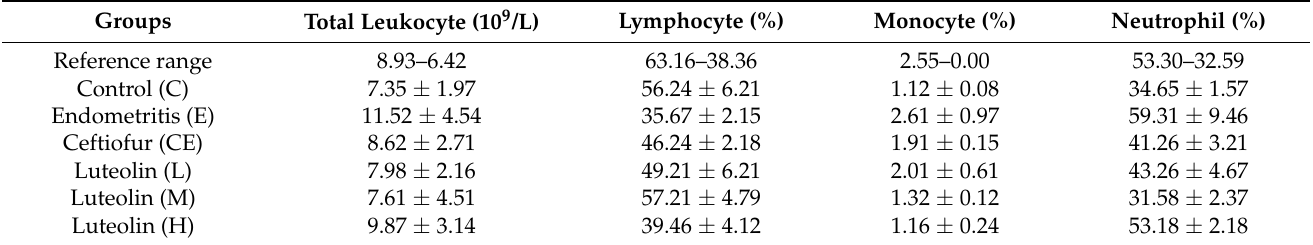
Table 2. Mean ± SEM values of leukocyte count in various experimental